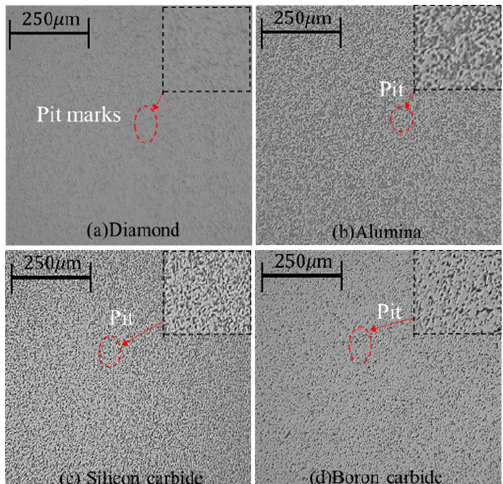
Figure 8. Microscopic appearance of samples with different abra- sive